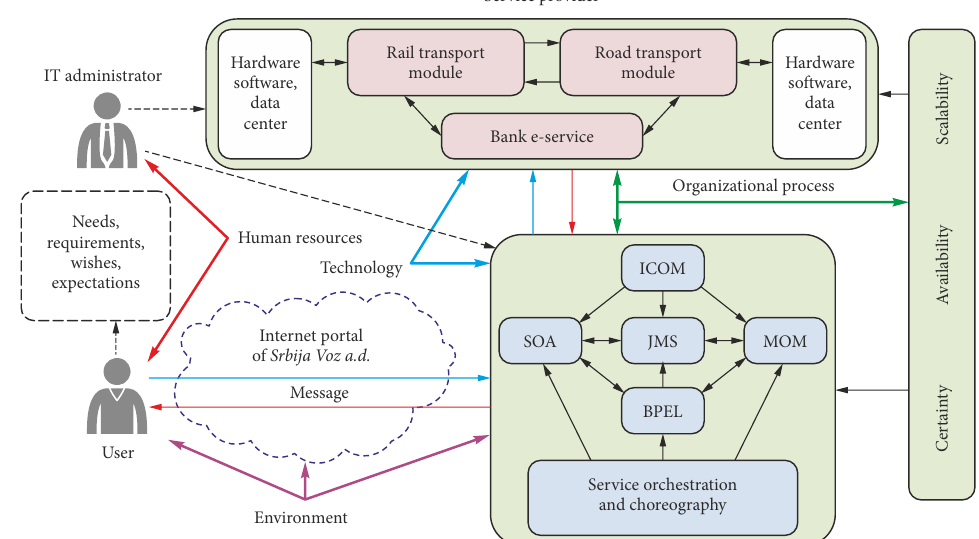
Figure 4. Modelling of the architecture of a contactless ICT transaction